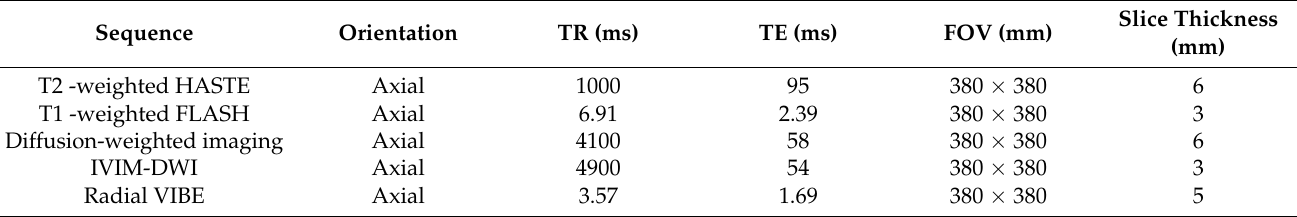
Table 1. MR imaging sequence